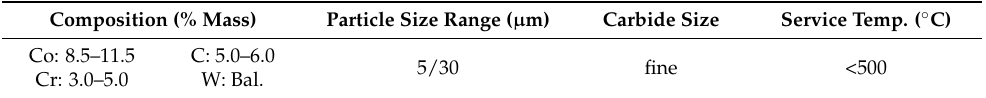
Table 1. Characteristics of WC–CoCr feedstock powder.